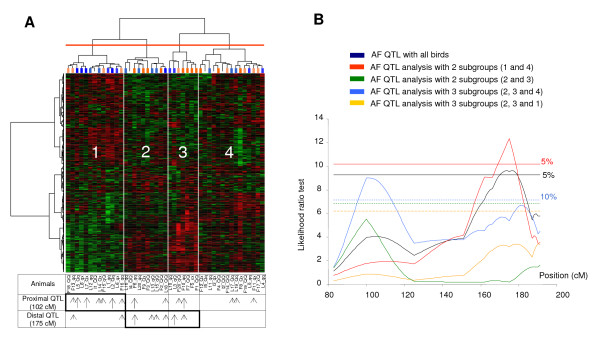
Two-way Hierarchical Cluster Analysis (HCA) of the 45 animals and 660 gene-set (A) and AF QTL analyses (B). (A) HCA color matrix display obtained with the 660 genes (Y axis) and the 45 chickens (X axis). Dark/light blue bars indicate the 20 fattest chickens (dark bars correspond to the extreme fat chickens (F1 to F10), light bars the next (F11 to F20)); dark/light orange bars indicate the 20 leanest chickens (dark bars correspond to the extreme lean chickens (L1 to L10), light bars the next L11 to L20); colorless bars correspond to the 5 intermediate chickens (I). The two final letters of the animal labels, indicate the Q or q haplotype inherited from the sire, with a probability > 95% for the QTL at 102 cM (first letter) or the QTL at 175 cM (second letter); × indicates a probability < 95%. For the two QTL, animals with discrepant AF values and q/Q haplotype are indicated by arrows. Long arrows indicate the 10 most extreme animals with AF value in discordance with q/Q haplotype. Short arrows indicate the 10 lowest extreme animals (F11 to F20 and L11 to L20). (B) Interval mapping for the AF trait on chromosome 5, with the whole family (blue) and without one or two subgroups observed by HCA (other colors). The chromosome-wide significance thresholds at the 5% level (-) are displayed. The 10% level (- -) obtained for analysis without subgroups 1 (light blue), 4 (yellow) or 1 and 4 (green) are also displayed. The genetic distances (cM) and likelihood ratio test (LRT) are shown on the X-axis and Y-axis, respectively.